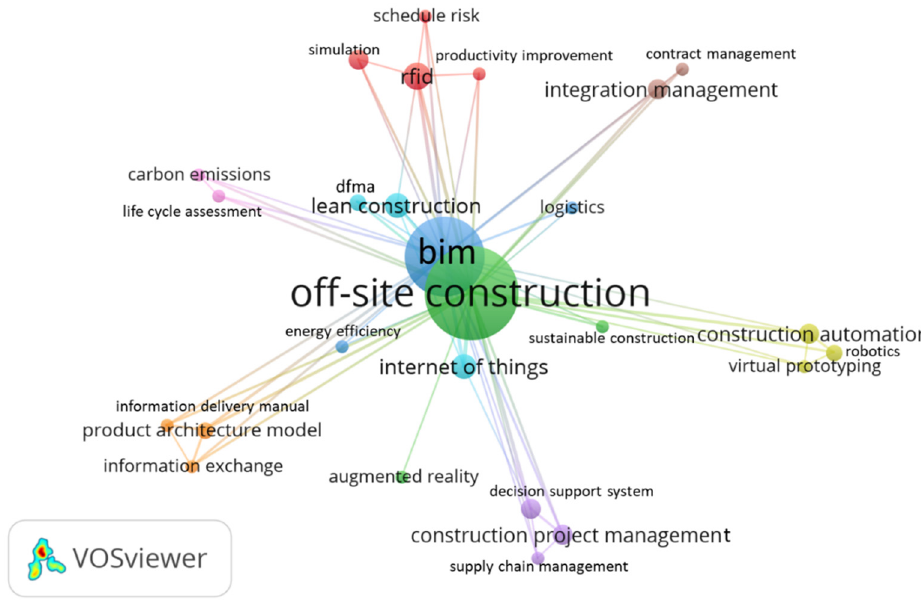
Figure 5. Mapping results of the co-occurrence of author keywords.